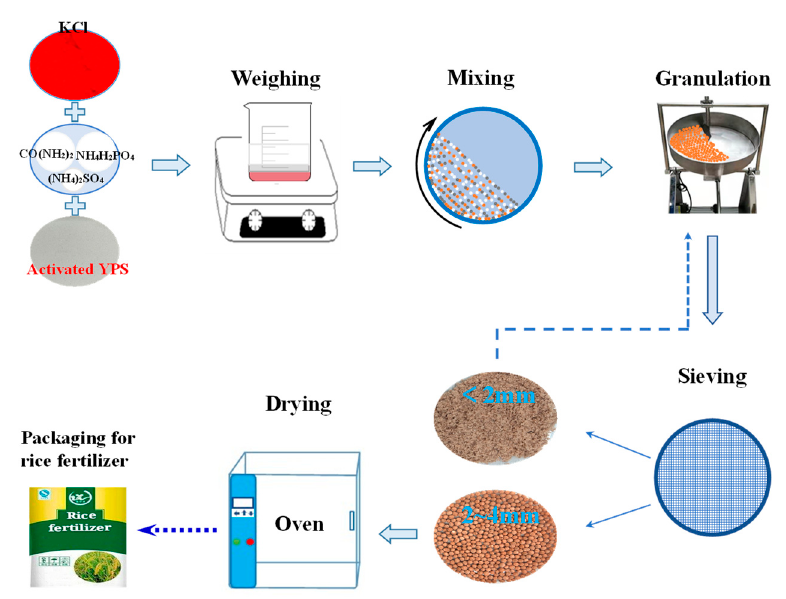
Figure 3. Preparation process of granular rice fertilizer.